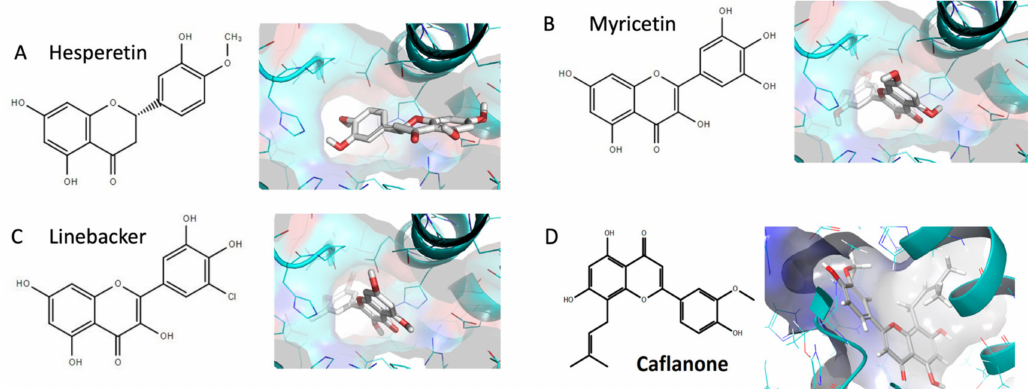
Figure 1. Docking studies for ( A ) Hesperetin; ( B ) Myricetin; ( C ) Linebacker; ( D ) Caflanone